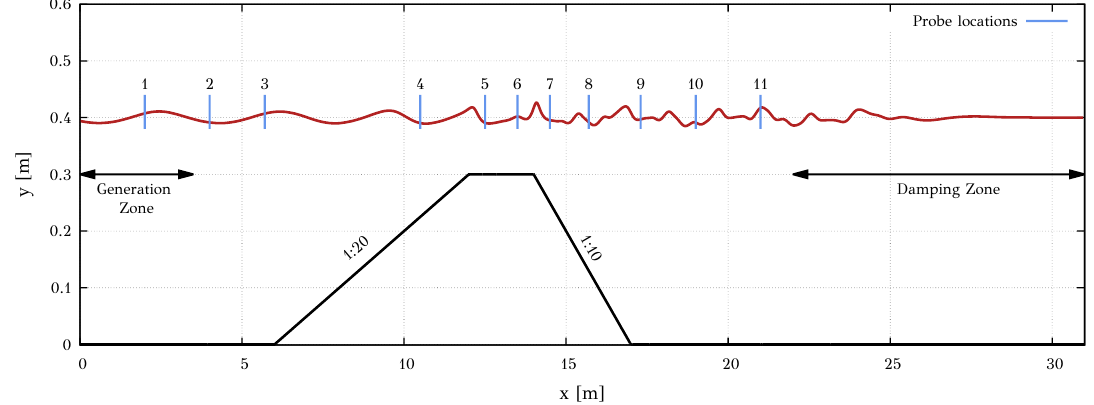
Figure 7. Numerical setup of the wave interaction with variable bathymetry test